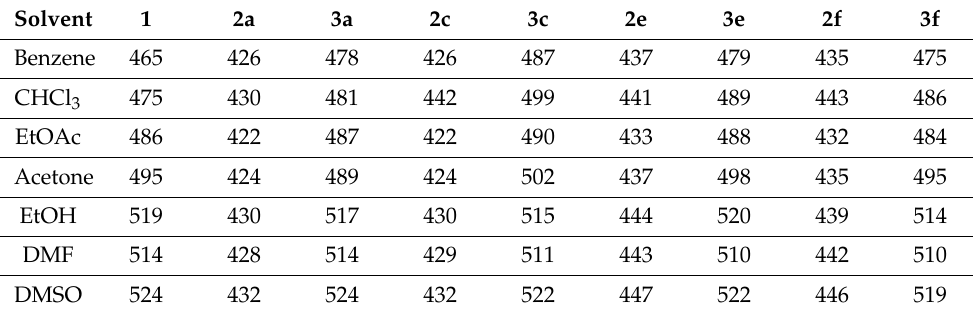
Table 2. Absorption maxima (in nm) of obtained derivatives in various organic solvents.